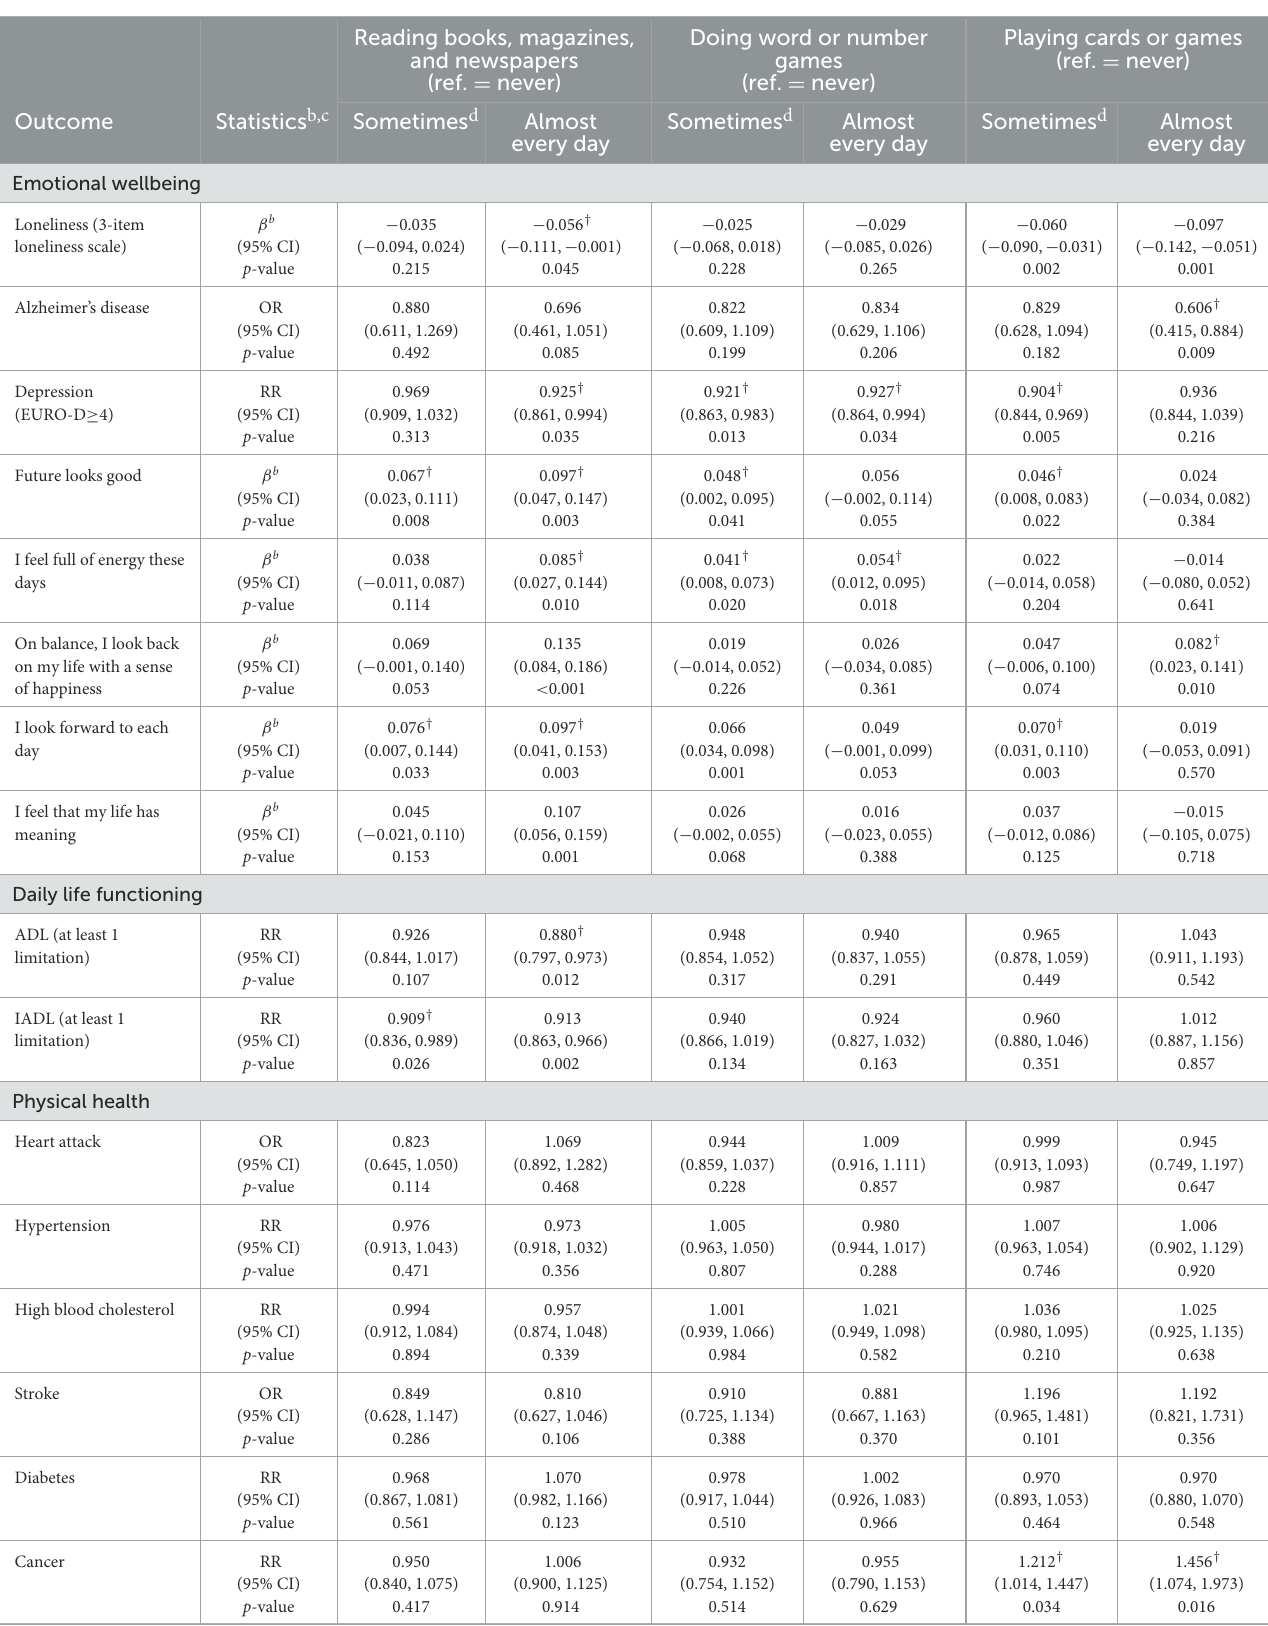
TABLE 3 Prospective associations between reading books, magazines, or newspapers, doing word and number games and playing cards or games, and wellbeing, physical health, daily life functioning, cognitive impairment, and all-cause mortality a . Reading books, magazines, and newspapers (ref. =